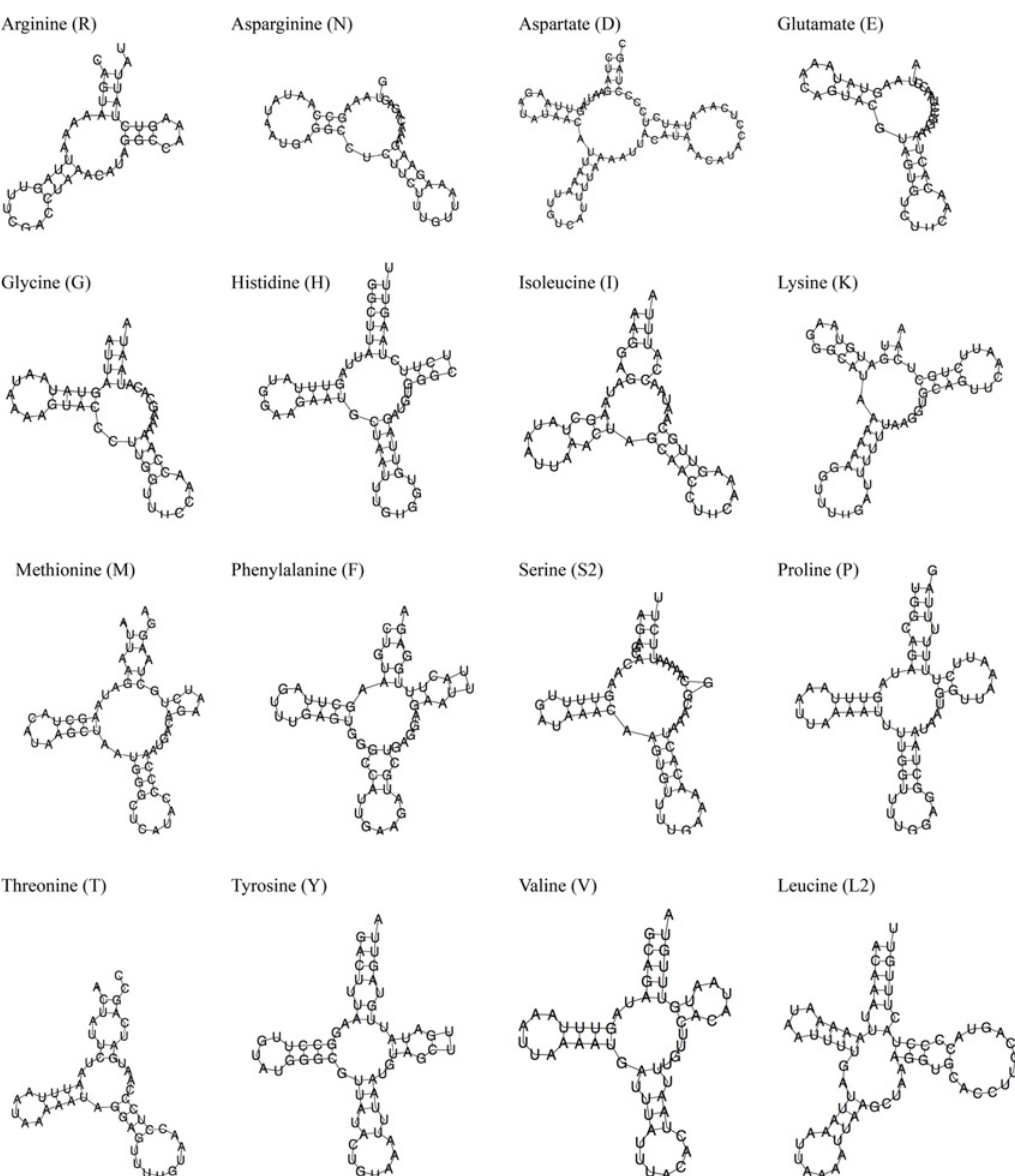
Fig 2. Putative secondary structures of tRNAs from the mitochondrial genome of Strigamia maritima as predicted by MiTFi [40,